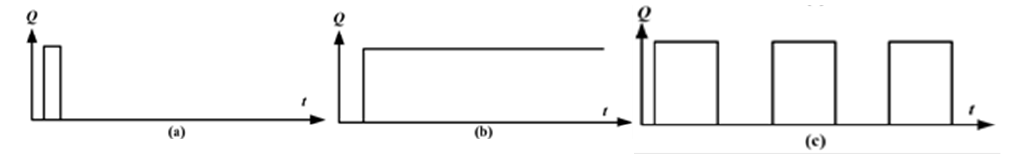
Figure 3. Excitation functions of MWT: ( a ) MPT; ( b ) MST; ( c ) MLT.